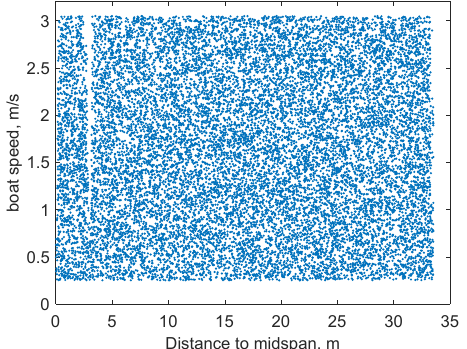
Figure 14. Learning database for ANN training and testing.